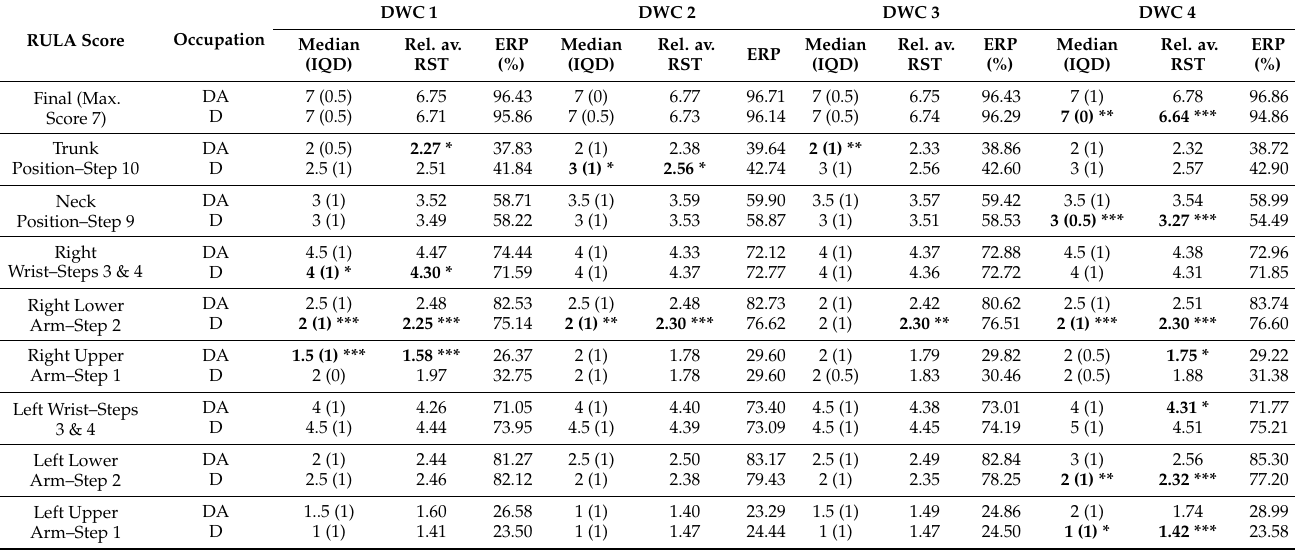
Table 1. Median, relative average risk score over the time, and maximum score for all evaluated RULA steps, dental workplace concepts (DWCs), and both occupations. Comparison between the occupations: the occupation with the significantly smaller ergonomic risk is marked with asterisks and bold font (* p < 0.05; ** p < 0.01; *** p < 0.001). The alpha error was adjusted according to